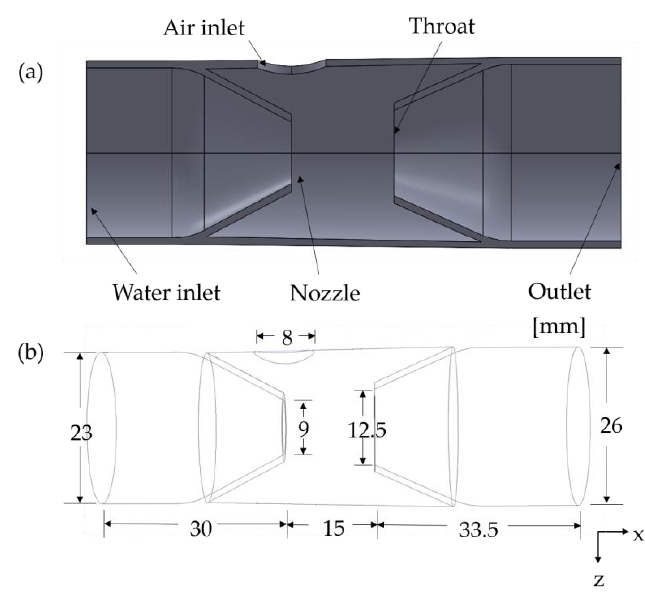
Figure 1. The micro – nanobubble generator ’s ( a ) sectional view and ( b ) dimension drawing. Figure 1. The micro–nanobubble generator’s ( a ) sectional view and ( b ) dimension